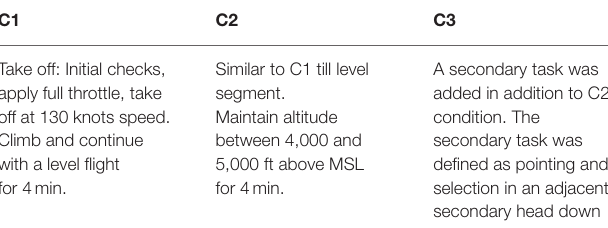
TABLE 9 | Task scenarios for Flight simulator